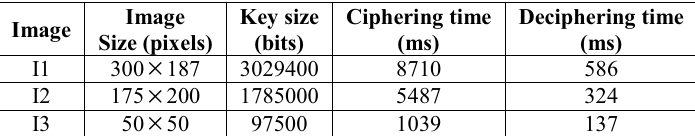
Table 6. Results obtained by